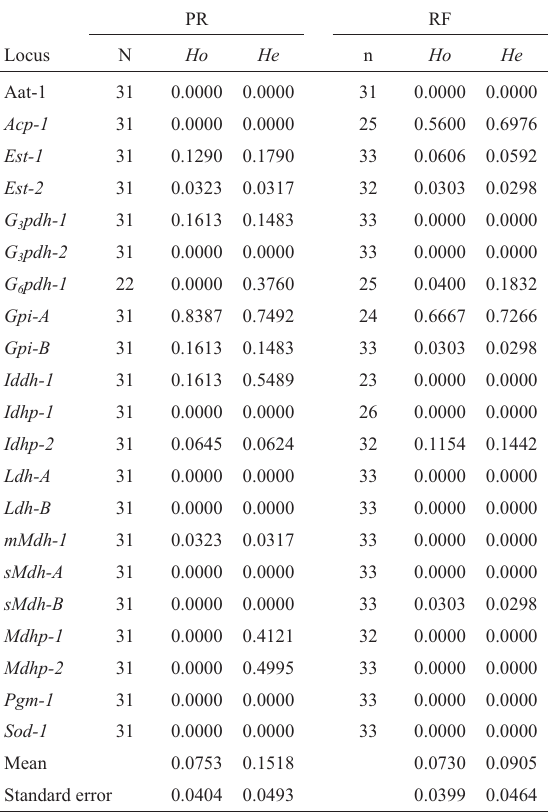
Table 2 - Obtained ( Ho ) and expected ( He ) heterozygosity per locus of Astyanax altiparanae from the Upper Paraná River (PR) and Ribeirão Ficha